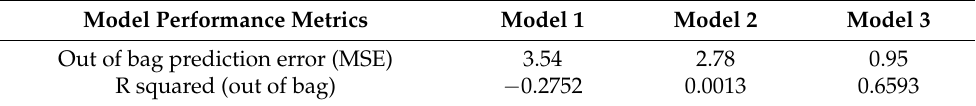
Table 1. Model performance metrics of Model 1: yield~aNDVI, Model 2: yield~maxNDVI, and Model 3: yield~aNDVI + maxNDVI + Jan_P + Feb_P + Mar_P + Apr_P + May_P + Jun_P + Jul_P +